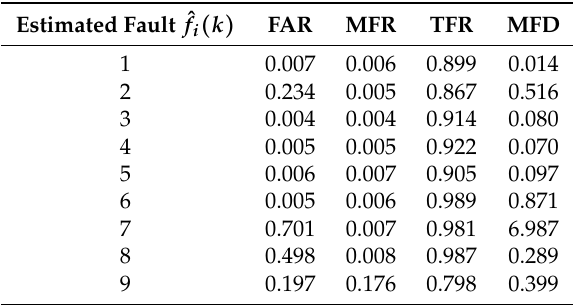
Table 10. Performance indices with NN fault